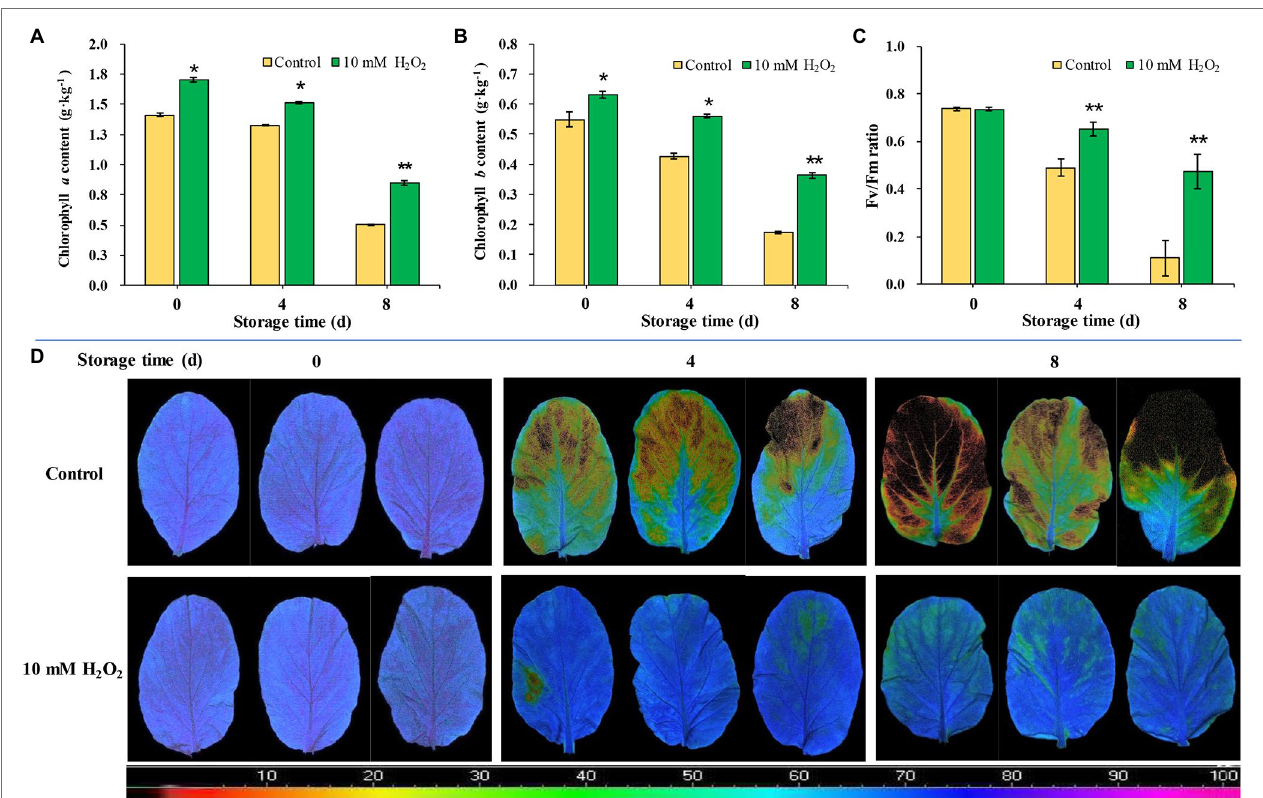
FIGURE 4 | The effects of preharvest application of 10 mM H 2 O 2 on Chlorophyll contents and photochemical efficiency of Chinese flowering cabbage leaves during storage. The chlorophyll a (A) and chlorophyll b (B) contents, Fv/Fm value (C) , and chlorophyll fluorescence images (D) of Chinese flowering cabbage leaves during storage. The images were color-coded based on the Fv/Fm value. The blue- to purple-coded area indicates healthy leaves, whereas the yellow to the dark-red- coded area indicates disfunction of photosystem II function in leaves. Error bars represent one SD. Asterisks indicate that the mean values of H 2 O 2 treatment are significantly different from those of the control (* p < 0.05, ** p < 0.01), according to Duncan’s multiple range